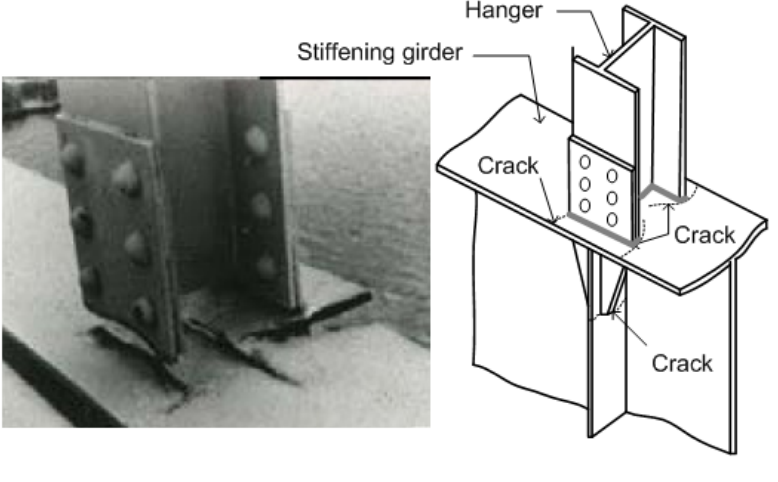
Figure 8. Fatigue cracking in the hangers of the Mashita Bridge in Japan